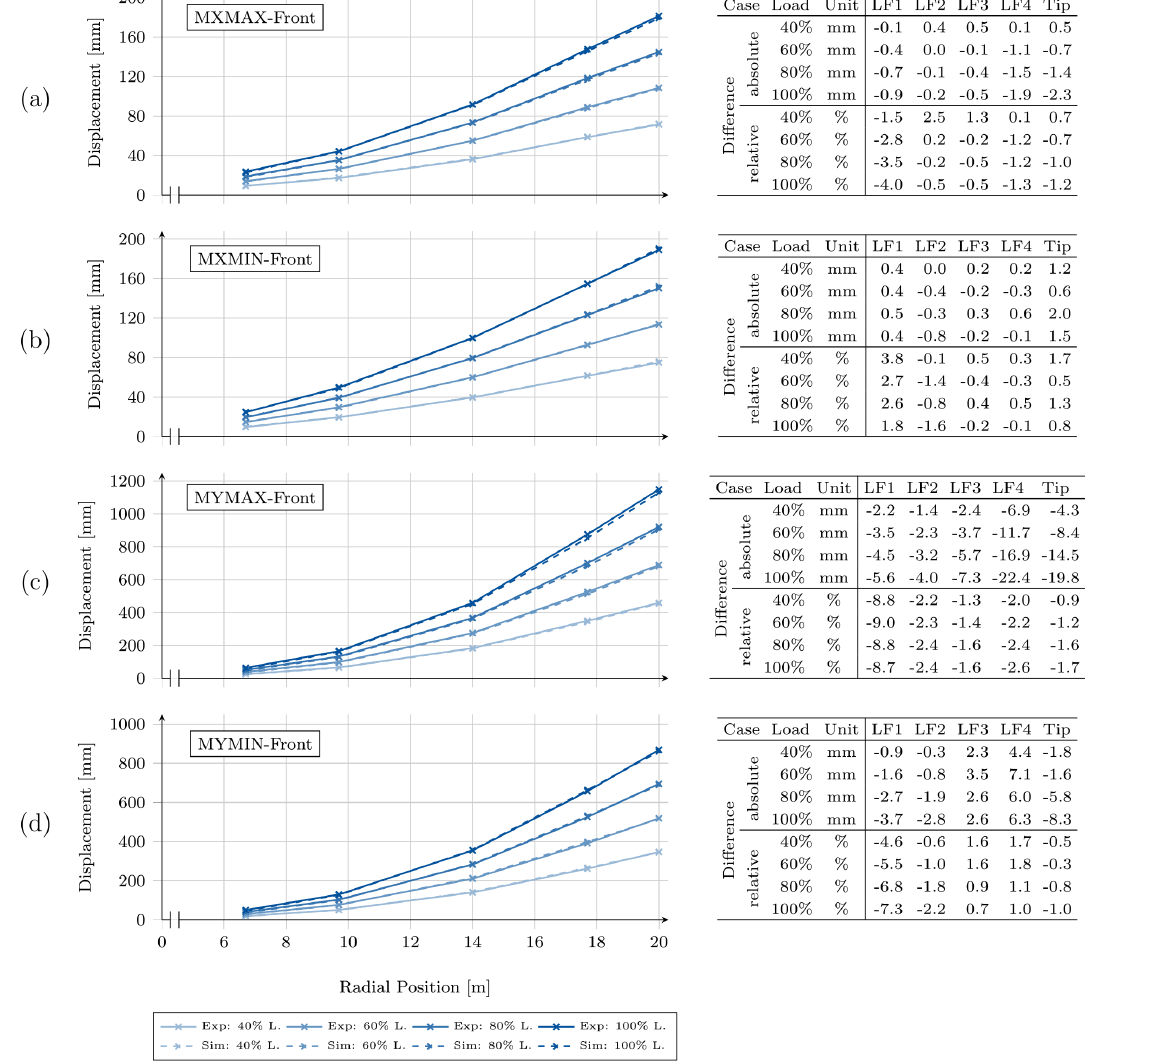
Figure 11. Bending lines extracted from the front draw-wire sensor for the (a) MXMAX, (b) MXMIN, (c) MYMAX, and (d) MYMIN experiment and simulation. Results are shown for 40%, 60%, 80%, and 100% of the target load. The table on the right shows the differences between the simulation and the